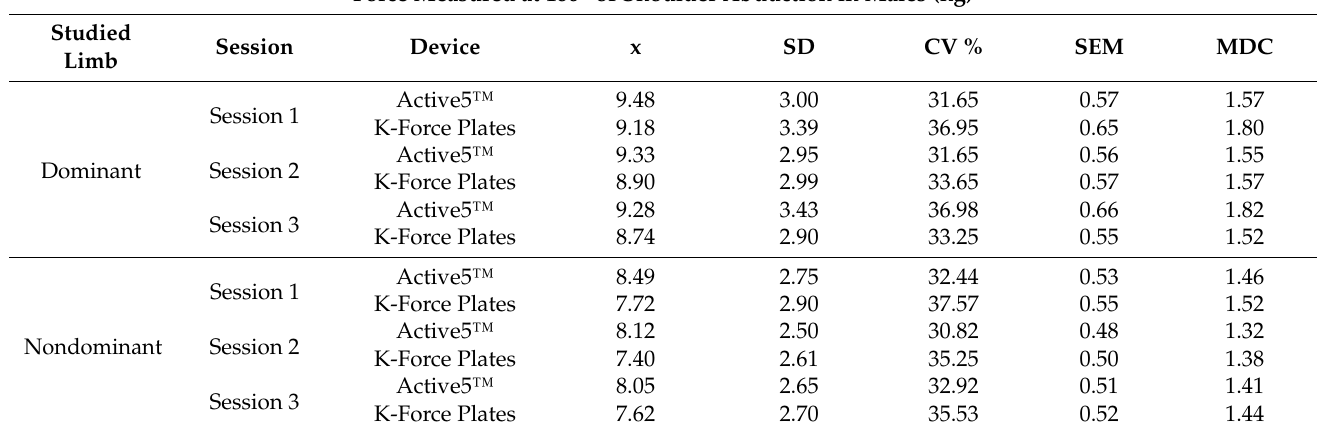
Table 11. The results of force measurements at 180 ◦ shoulder abduction using Active5™ and K- Force